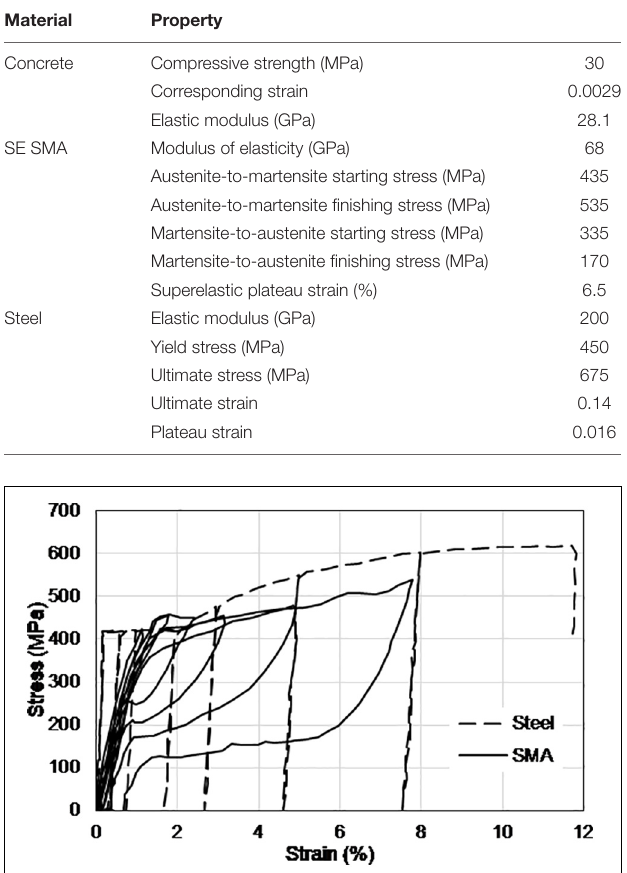
TABLE 3 | Material properties for SMA-RC and Steel-RC bridge pier.